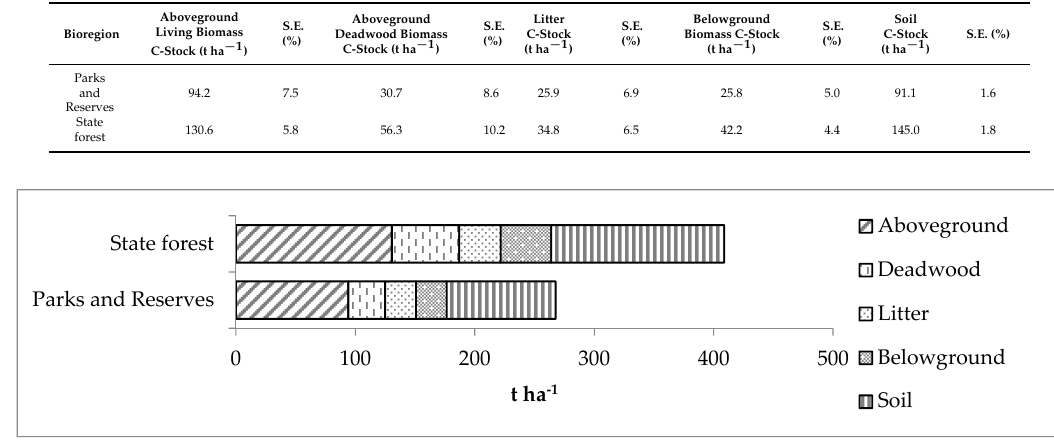
Table 3. Public land forest area within bioregions and estimated carbon stock per hectare (with standard errors) for different carbon pools.